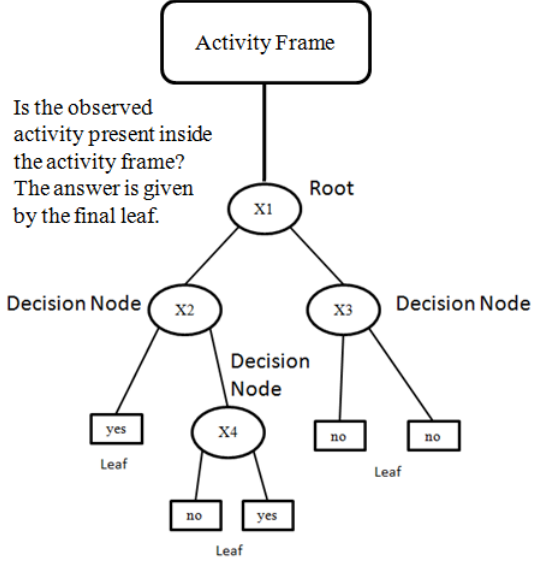
Figure 7: Structure of the decision tree used in this work. Each tree is created for a different activity. The final leaf contains a binary state prediction whenever that observed activity is present inside the activity